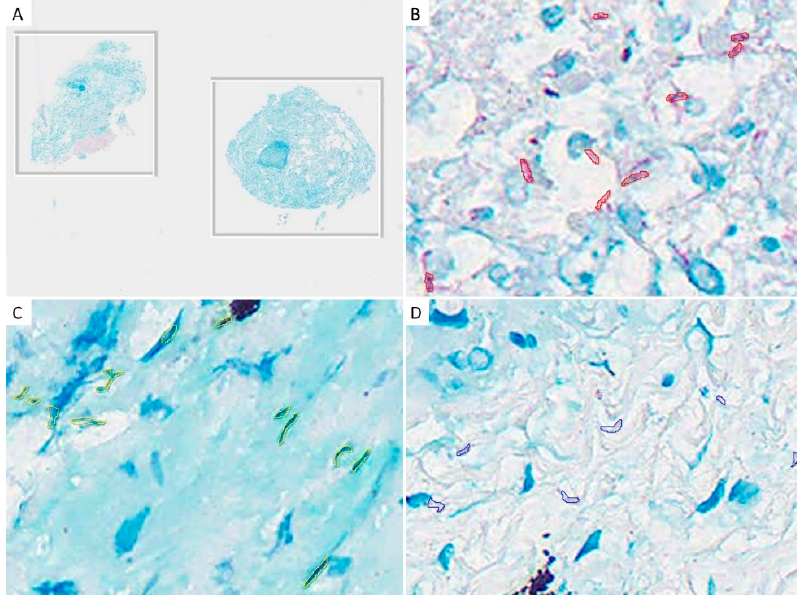
Figure 1. Examples of annotations: ( A ) Ziehl–Neelsen staining tissues, which do not contain acid- fast bacilli (AFB), for the purpose of training the background other than AFB. No annotation was performed; ( B ) We annotated short-rod-shaped bacilli that were stained red in Ziehl–Neelsen staining as AFB; ( C ) Nuclei of type I epithelial cells showing AFB-like morphology, annotated as artifact 1; ( D ) Part of the fibrin-stained purple, annotated as artifact 2.